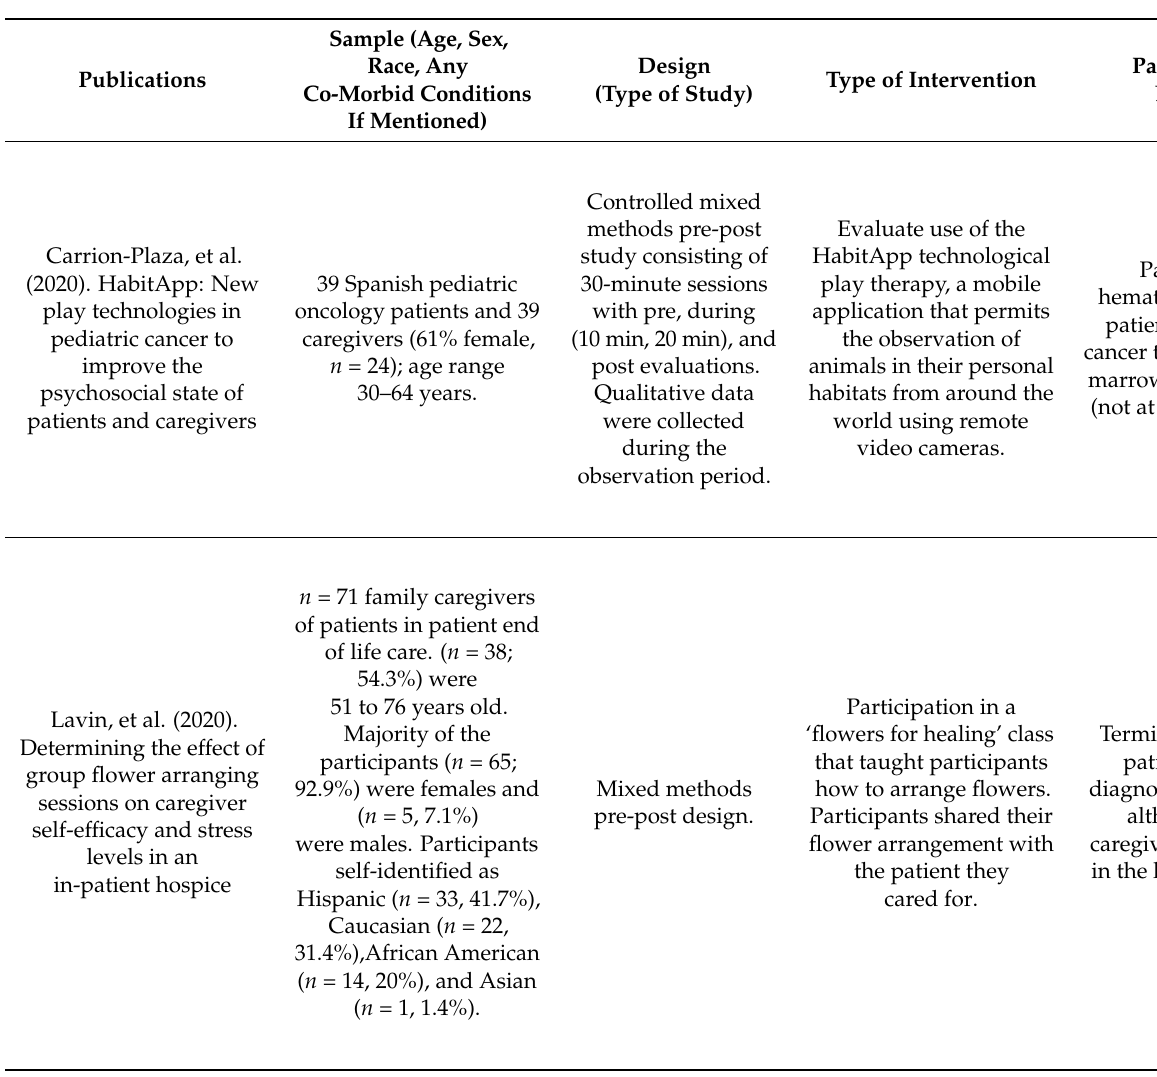
Table 1. Publications addressing nature-relevant interventions for informal family/friend cancer